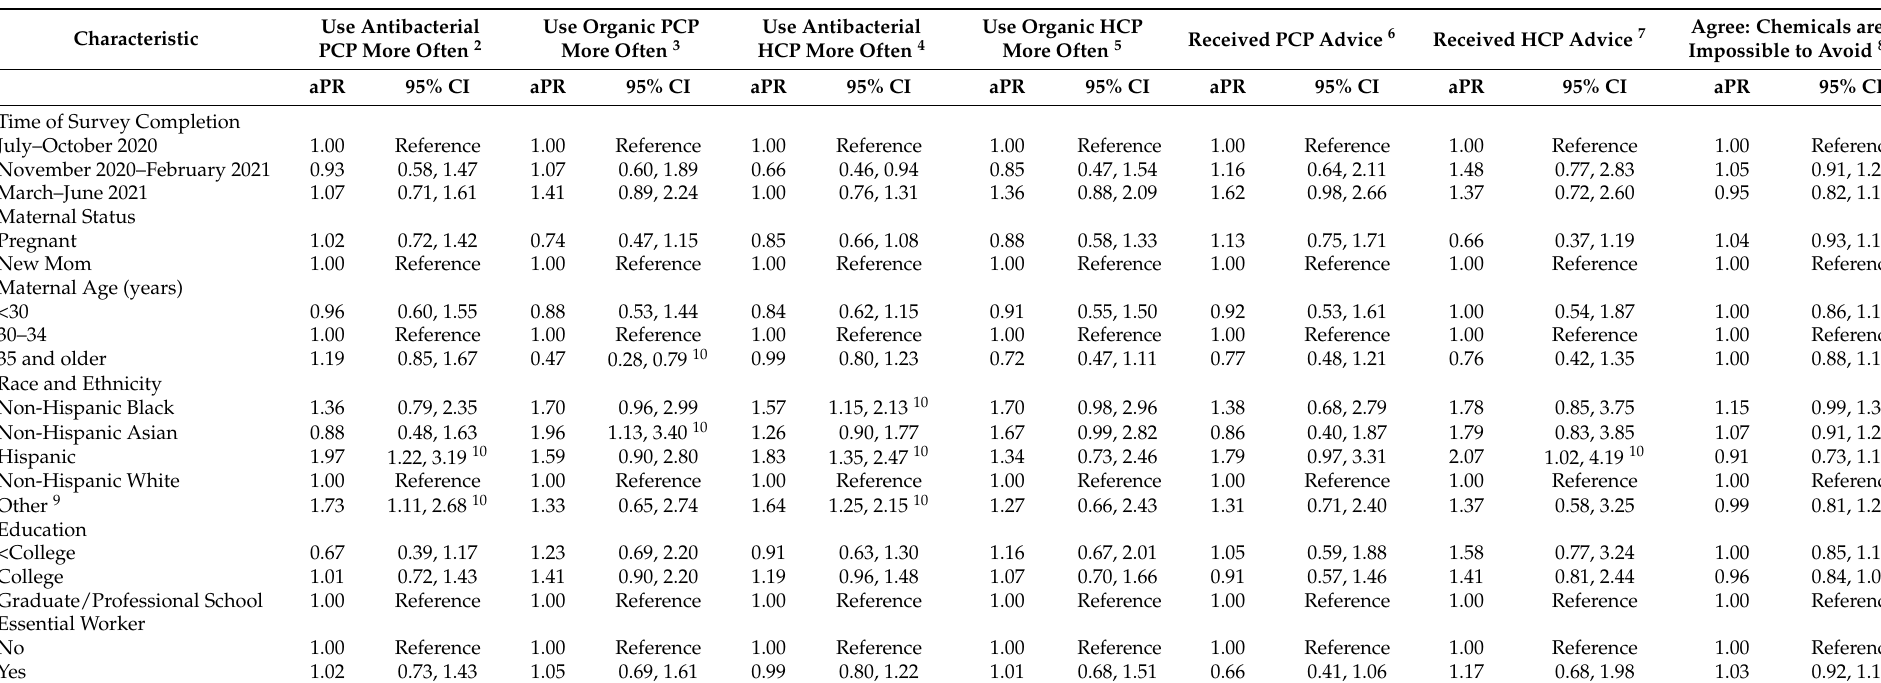
Table 4. Multivariable robust Poisson regression analyses 1 estimating adjusted prevalence ratios (aPR) for change in use of antibacterial and organic personal care products (PCP) and household cleaning products (HCP) during the pandemic (compared to before March 2020), receipt of healthcare provider advice on use of PCP and HCP, and agreement that environmental chemicals are impossible to avoid by selected maternal characteristics among women in the Maternal Health and Behavior Study (n =